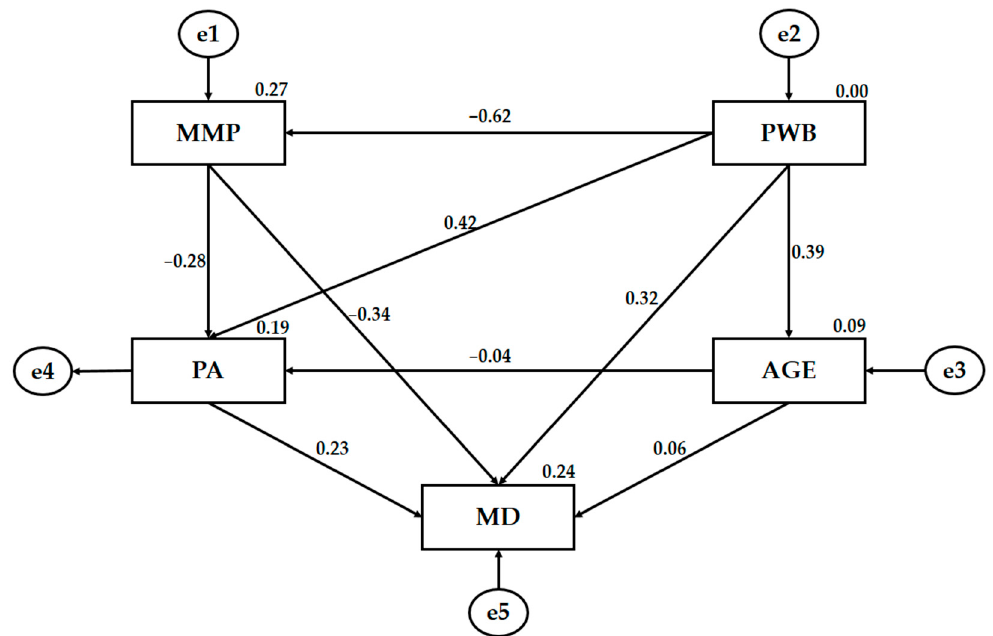
Figure 4. The structural equation for males. Note: Mass media pressure (MMP); Mediterranean diet (MD); physical activity (PA); psychological well-being (PWB); age (AGE); error (e). Table 2. The structural model for males. Associations between